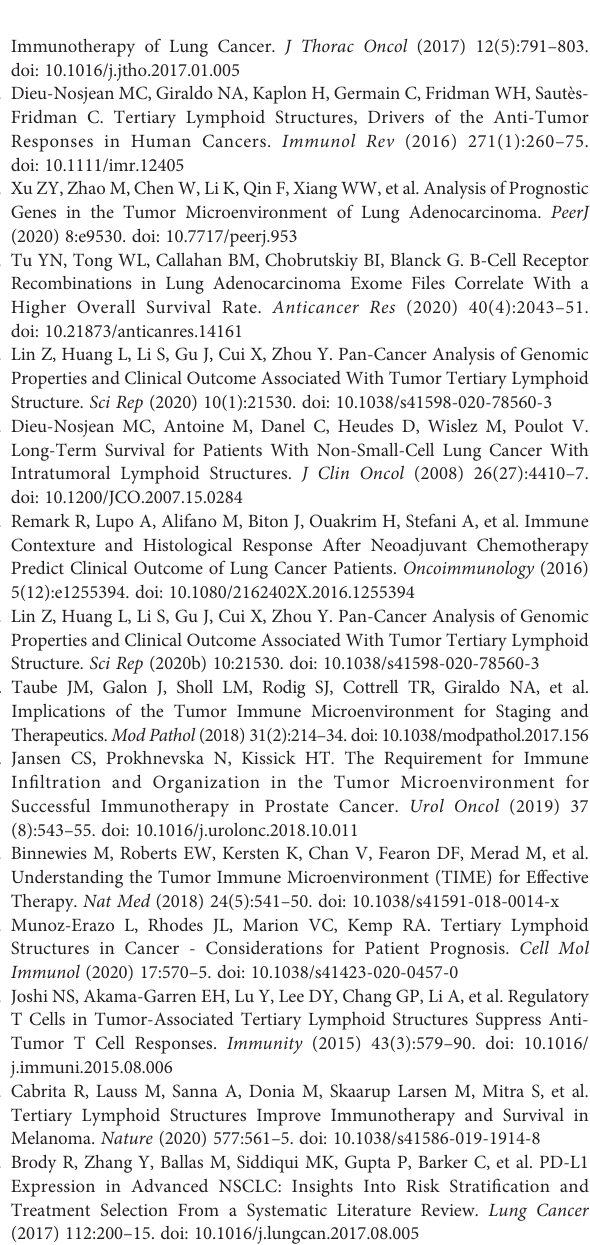
Supplementary Figure 4 | Heapmap of the expression of checkpoint genes between the TLS signature high and low groups. TLS signature high (n=336) and low groups (n=169). Supplementary Figure 5 | Relationship between TLS signature and PFI of patients with given mutation status of driver genes. (A) Differences in PFI of patients with wild type (high group n=289, low group n=144) or mutant EGFR (high group n=42, low group n=22) between the two indicated groups; (B) Differences in PFI of patients with wild type (high group n=237, low group n=108) or mutant KRAS (high group n=94, low group n=58) between the two indicated groups; (C) Differences in PFI of patients with wild type (high group n=302, low group n=155) or mutant BRAF (high group n=29, low group n=11) between the two indicated groups; (D) Differences in PFI of patients with wild type (high group n=171, low group n=74) or mutant TP53 (high group n=160, low group n=92) between the two indicated groups.